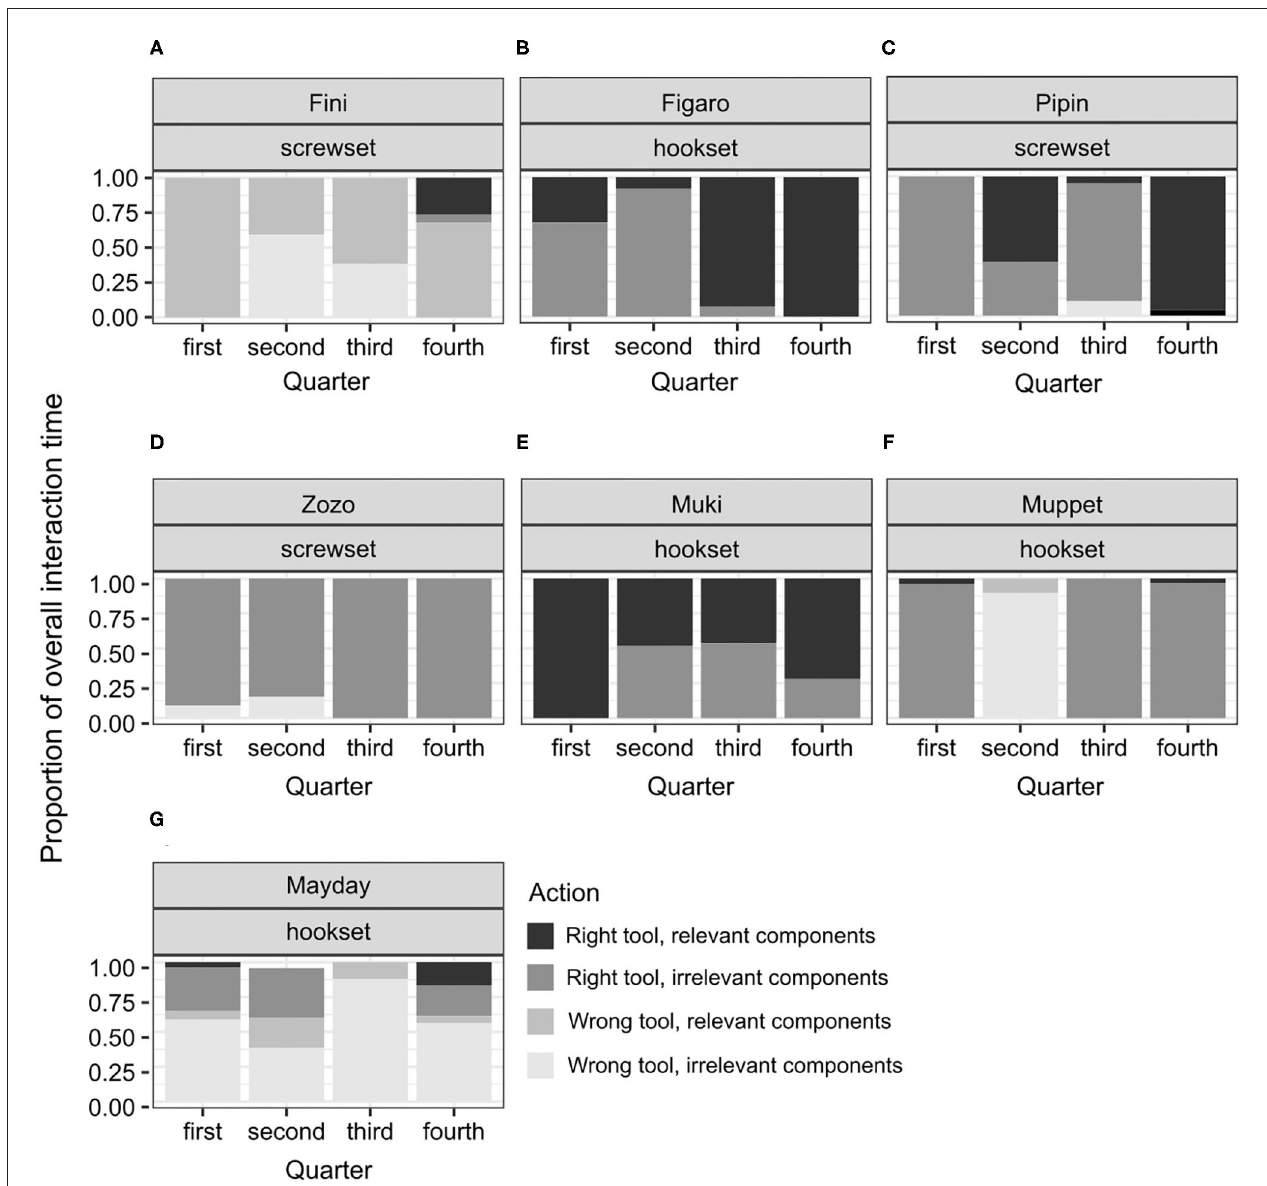
FIGURE 5 | A plot of the proportions of individual interaction times to the overall interaction time throughout the test in the no-conflict condition in successful subjects (A–C) , and unsuccessful subjects (D–G) . This display is based on the observed proportions.